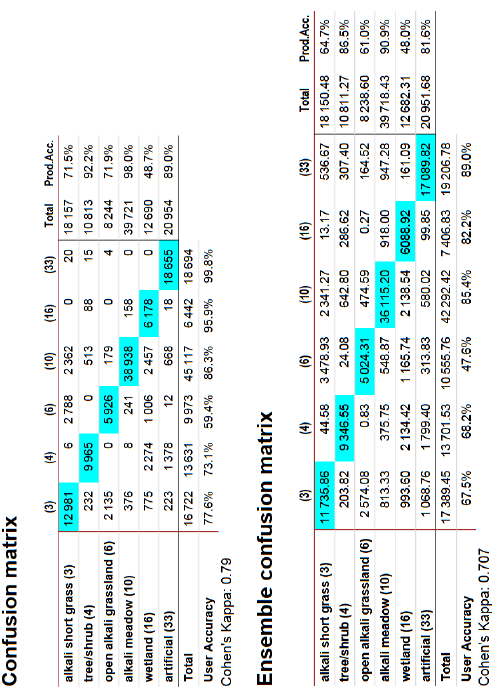
Table 1. Confusion matrix and ensemble confusion matrix representing the hard and fuzzy accuracy figures of the same Figure 2. RGB three-class rendering (a) with 3 classes mapped to individual color channels, Red: class 6 (open alkali grassland), Green: class 3 (alkali short grass), and Blue: class 10 (alkali meadow); and probability surplus map (b) of the same area